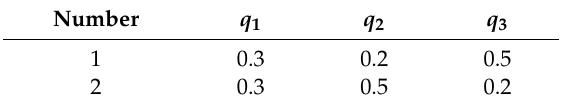
Table 4. The weight coe ffi cient of the improved cost function f ( n ) .